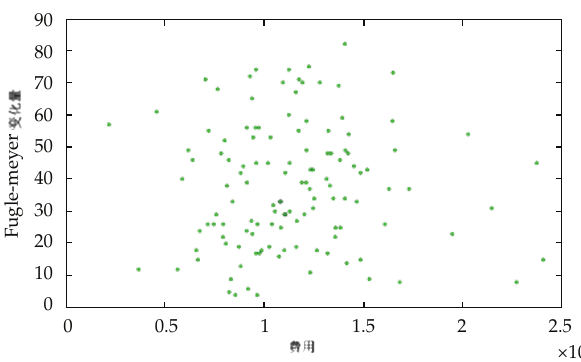
Figure 1: The scatter diagram of Fugle-Meyer baseline and total